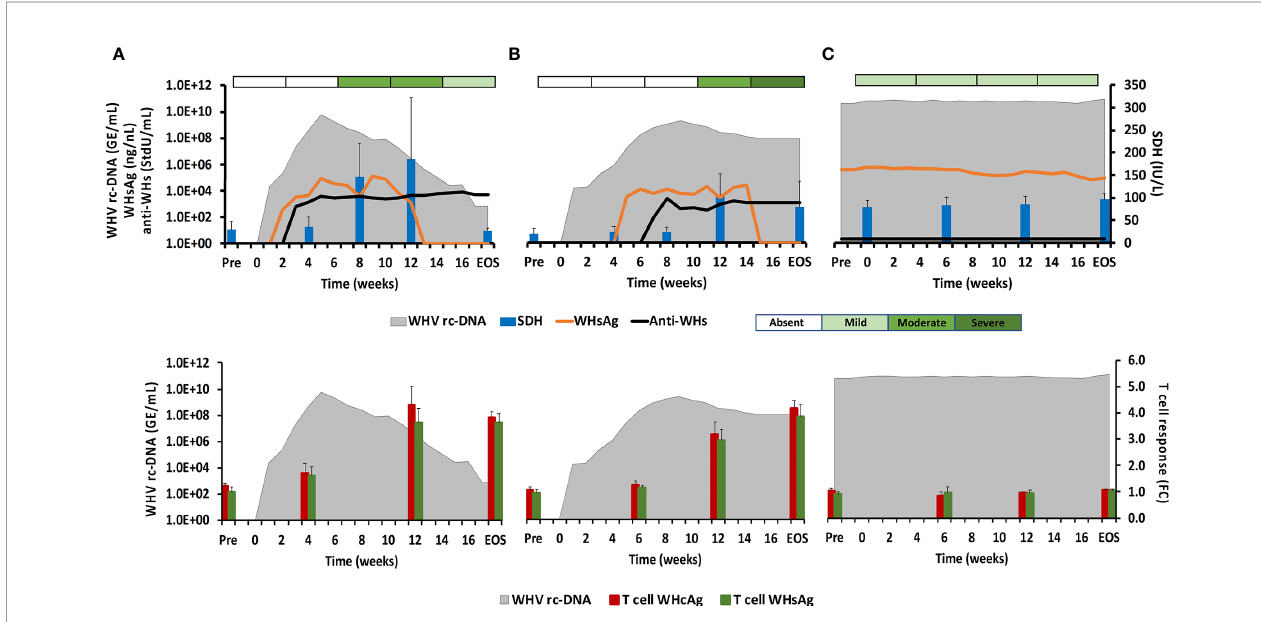
FIGURE 1 | Course of WHV infection in the periphery. Kinetics of serum viremia [WHV rc-DNA, as already reported (11, 12)] and antigenemia (WHsAg), antibody response (anti-WHs antibodies), liver enzyme (SDH) activity, and liver in fl ammation (top panels) and of blood T-cell response (speci fi c to WHcAg and WHsAg) with WHV rc-DNA kinetics (bottom panels) in woodchucks during (A) AHB with normal resolution (n=5), (B) AHB with delayed resolution (n=5), and (C) CHB progression (n=5). Changes in WHV rc-DNA, WHsAg, and anti-WHs antibodies are plotted on the left y-axes, while changes in SDH and WHcAg- and WHsAg-speci fi c T-cell responses are plotted on the right y-axes. Horizontal bars represent the standard error of the mean. The composite score for sinusoidal and portal hepatitis is represented as a scale bar, indicating absent, mild, moderate, or severe/marked liver in fl ammation. GE, genomic equivalents; IU, international unit; FC, fold-change in T-cell proliferation from unstimulated controls; Pre, pre-inoculation for AHB and start of study for CHB; EOS, end of